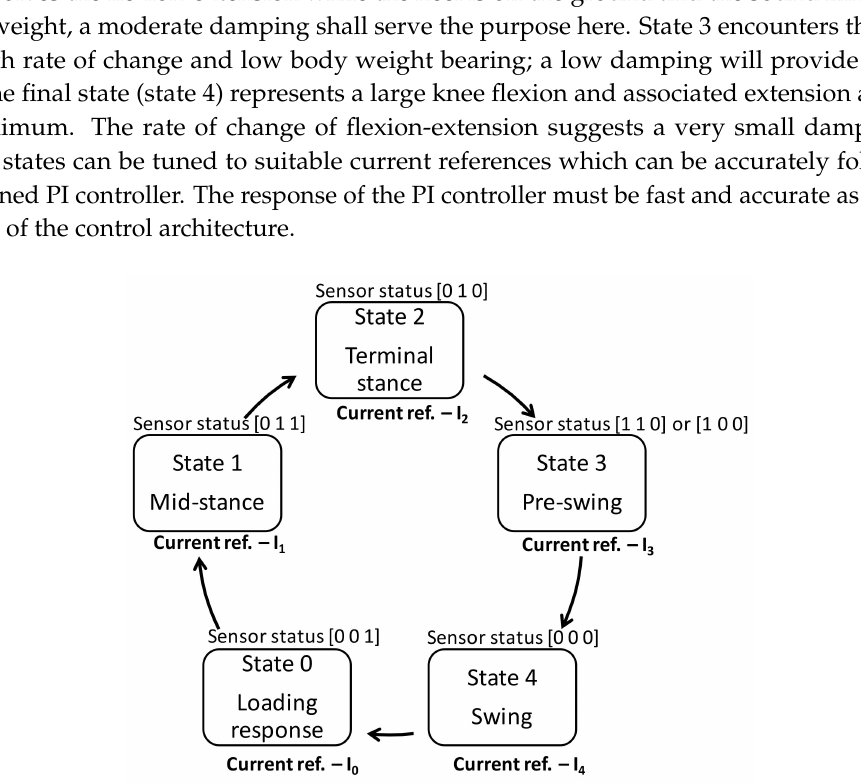
Figure 6. Finite state machine diagram.